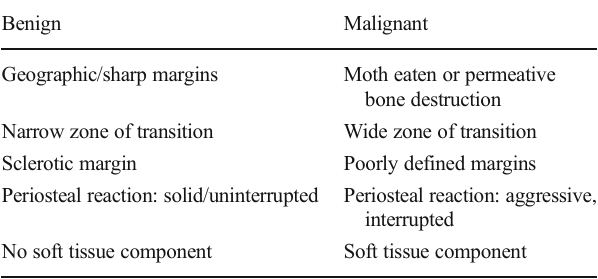
Features of benign and malignant lesions Benign Malignant Geographic/sharp margins Moth eaten or permeative bone destruction Narrow zone of